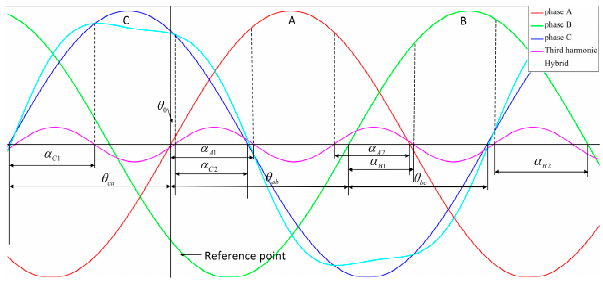
Figure 5. A hybrid compensation control schematic diagram.